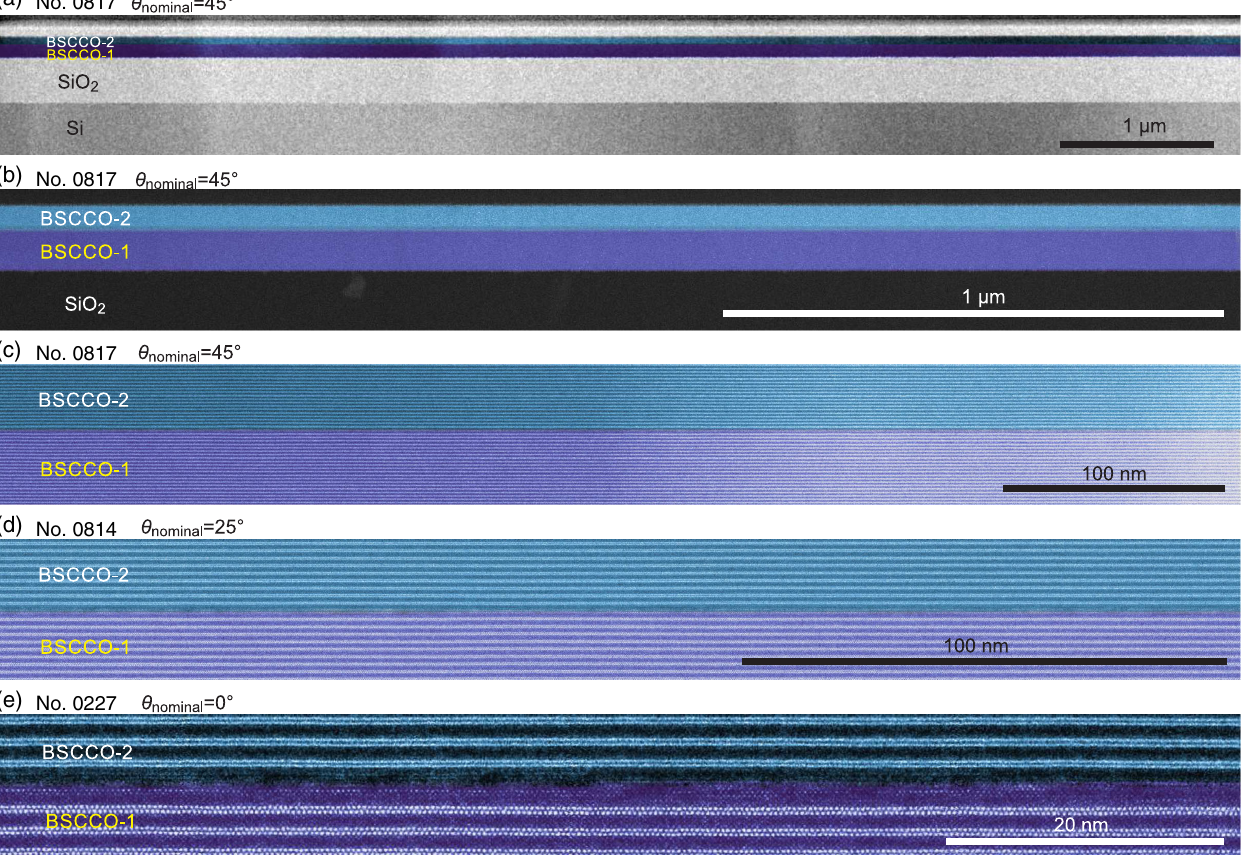
FIG. 2. (a) Cross-sectional TEM image of one sample over the entire region cut out by focused ion beam. (b) TEM image spanning about 2 . 5 μ m wide on the same sample shown in (a). (c) – (e) TEM images of the junctions with different twist angles illustrating the great uniformity of the samples. The horizontal range is approximately 560 nm for (c), 280 nm for (d), and 100 nm for (e).